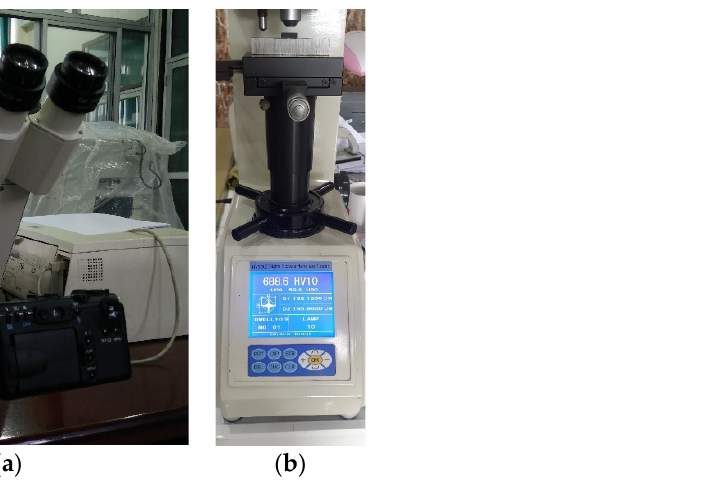
Figure 3. Equipment used in the tests: ( a ) Axiovert 25 CA Optical Microscope, ( b ) Brinell Hardness Tester.